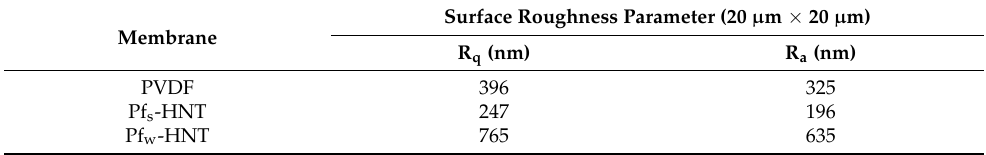
Figure 3. Three-dimensional and surface images of atomic force microscopy (AFM) for surface roughness analysis; PVDF, Pf s -HNT and Pf w -HNT membranes. Table 2. Comparison of the surface roughness between the neat PVDF, Pf s -HNT Pf w -HNT